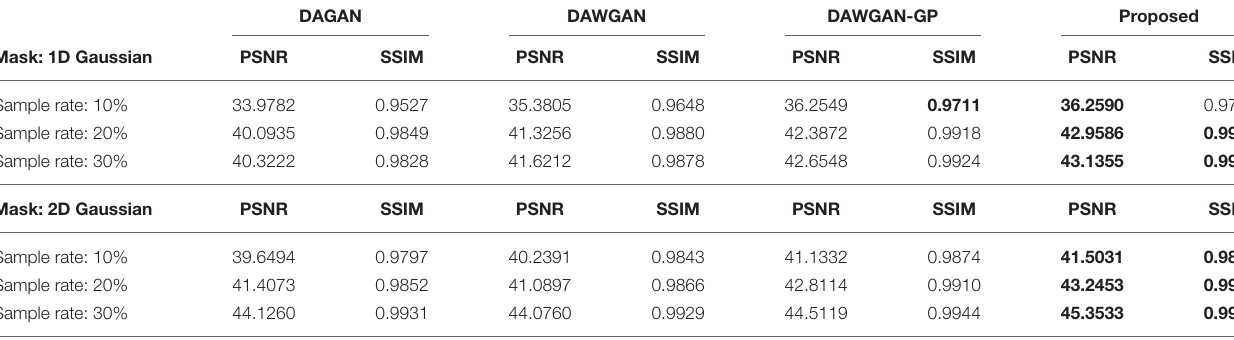
TABLE 3 | The average reconstruction performances of different methods on the test set with 40dB noise. DAGAN DAWGAN-GP Proposed